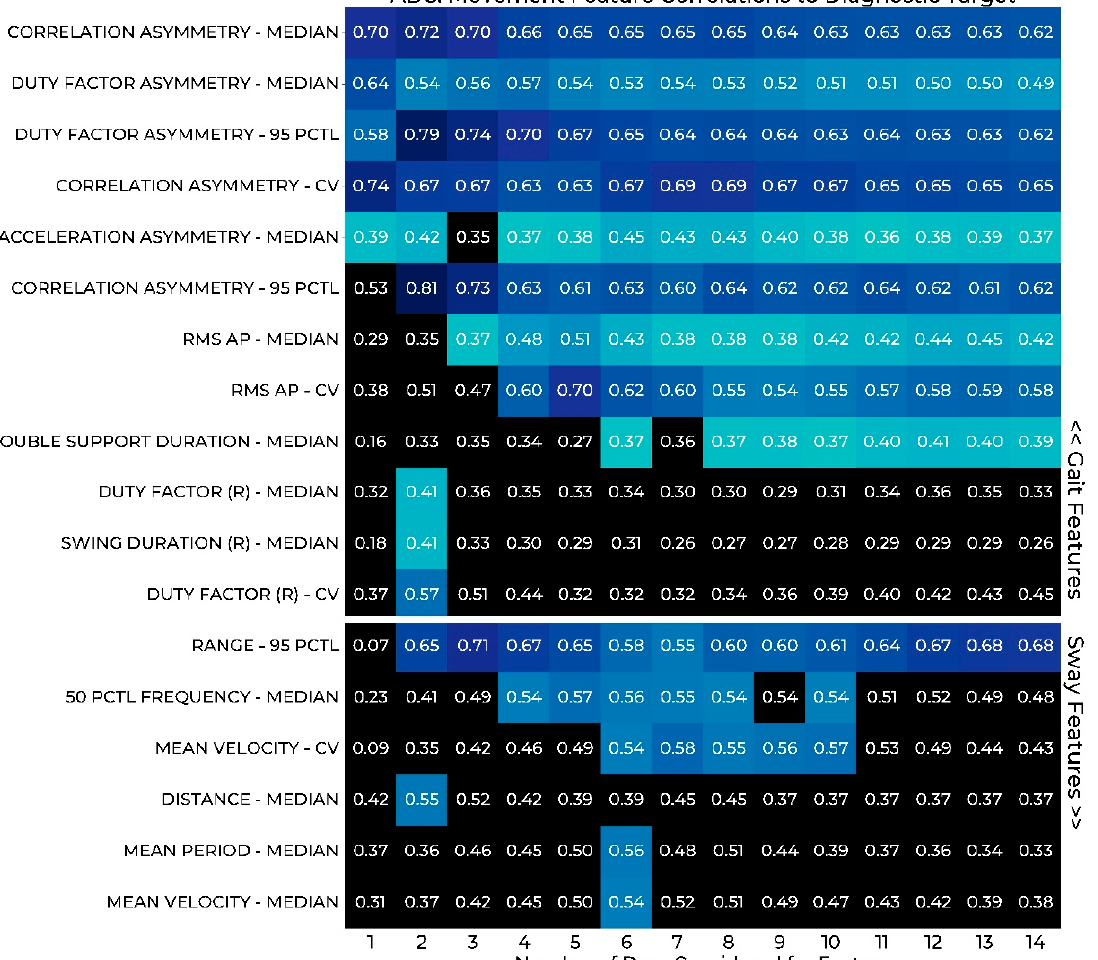
Figure 3. Spearman correlation between Modified Fatigue Impact Scale (MFIS) and measures of gait and postural sway by number of sensor-wear days. Cells shaded in blue represent significant